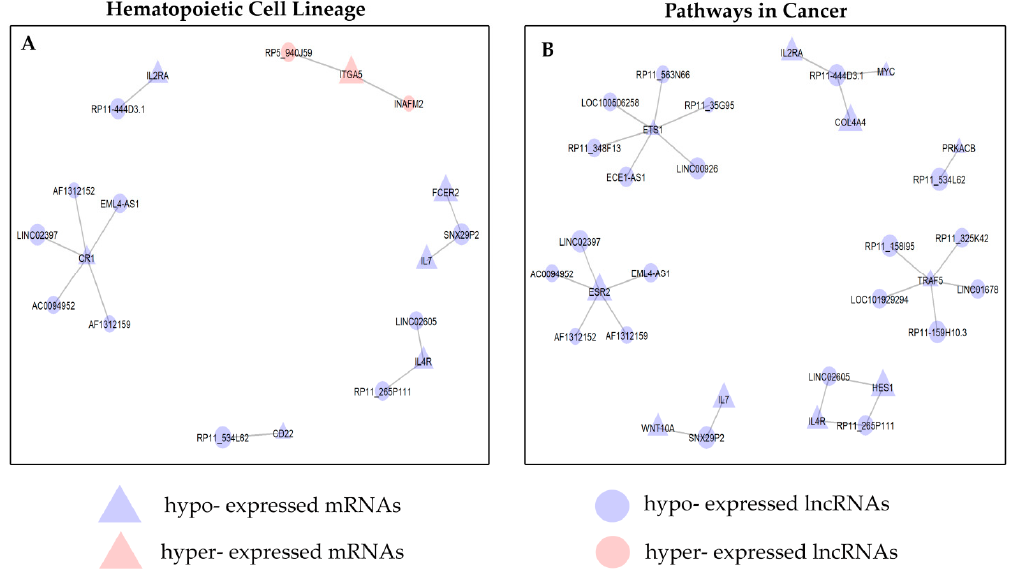
Figure 7. lncRNA–mRNA co–expression network. Network visualization of the KEGG enriched terms ( A ) “Hematopoietic cell lineage pathway” and ( B ) “Pathways in cancer”. The triangle and circular nodes represent mRNAs and lncRNAs, respectively. Red nodes represent increased expression comparing to healthy subjects and blue nodes represent decreased expression comparing to healthy subjects. lncRNA, long non–coding RNA.